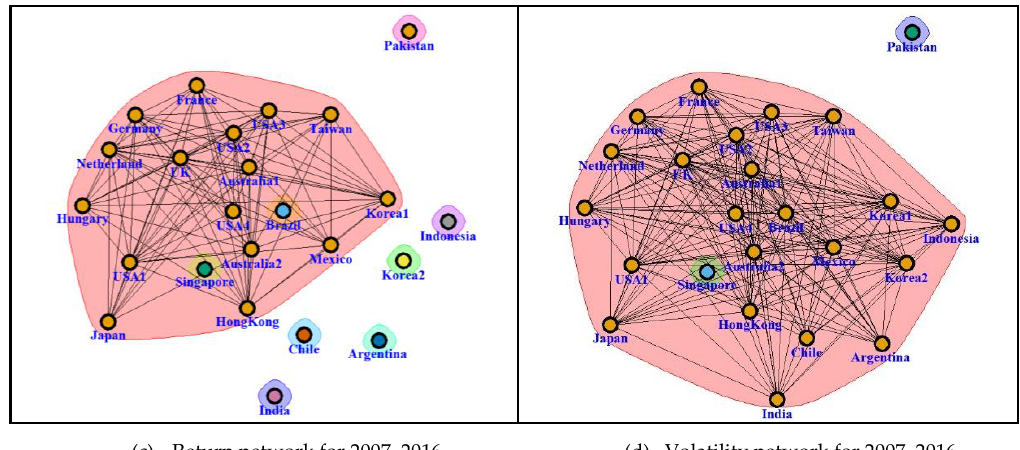
Figure 6. Community structures of return and volatility for global 24 stock markets of 10-year length time series. It has a huge community compared to four-year and 20-year time series. Additionally, the larger communities are formed in the volatility than the return, and in the second half rather than the first half.